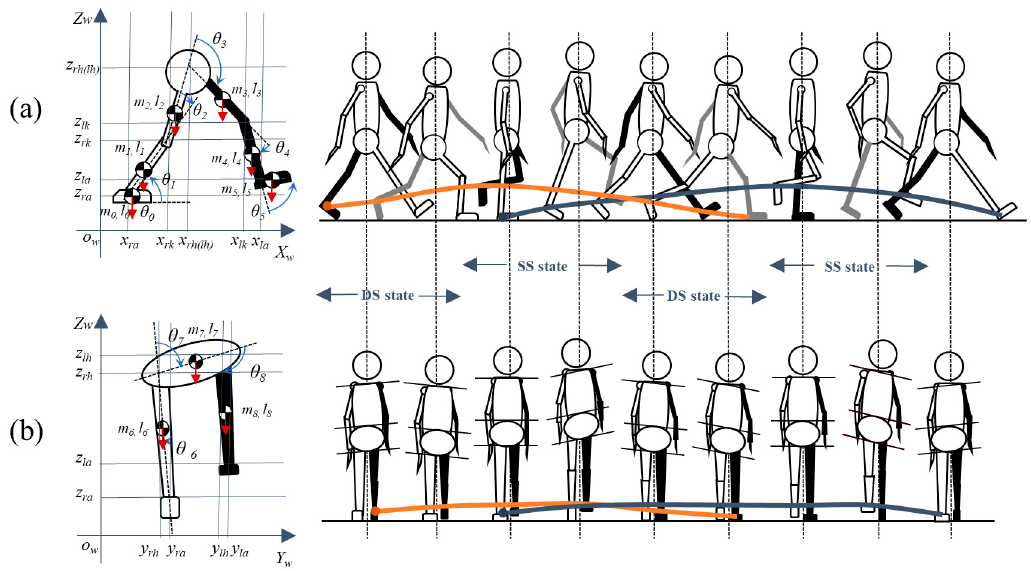
Figure 1. Walking dynamics during one cycle, which consists of two steps (left leg—solid black color, right leg—solid white color): ( a ) In the sagittal plane; ( b ) in the transverse plane.